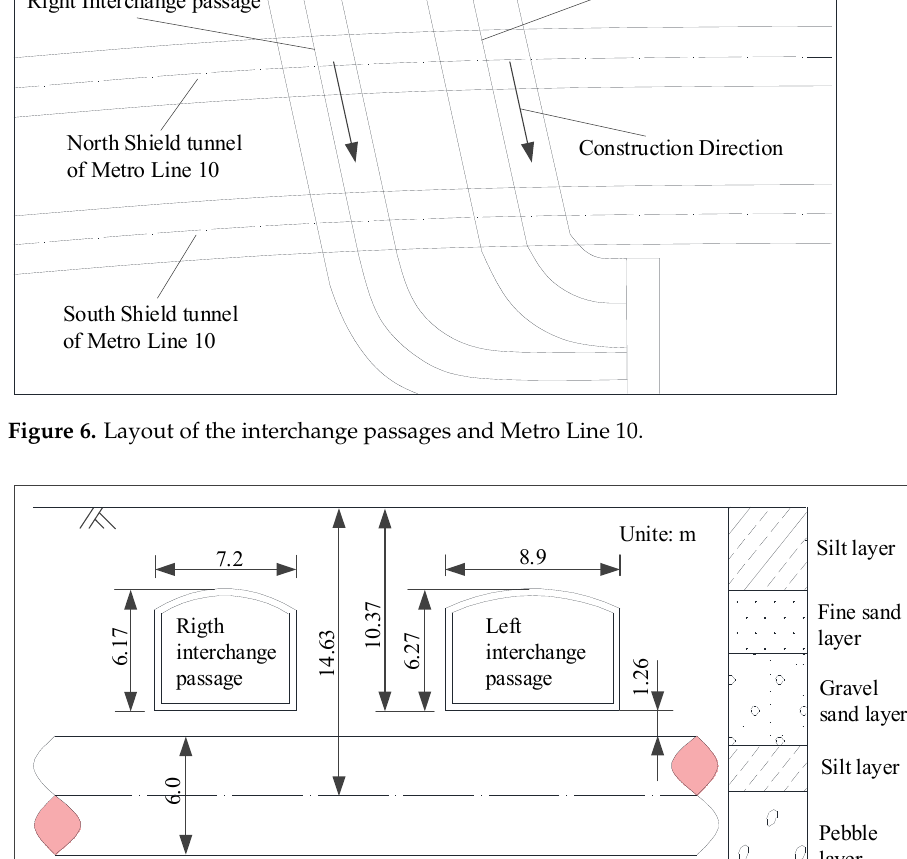
Figure 6. Layout of the interchange passages and Metro Line 10.